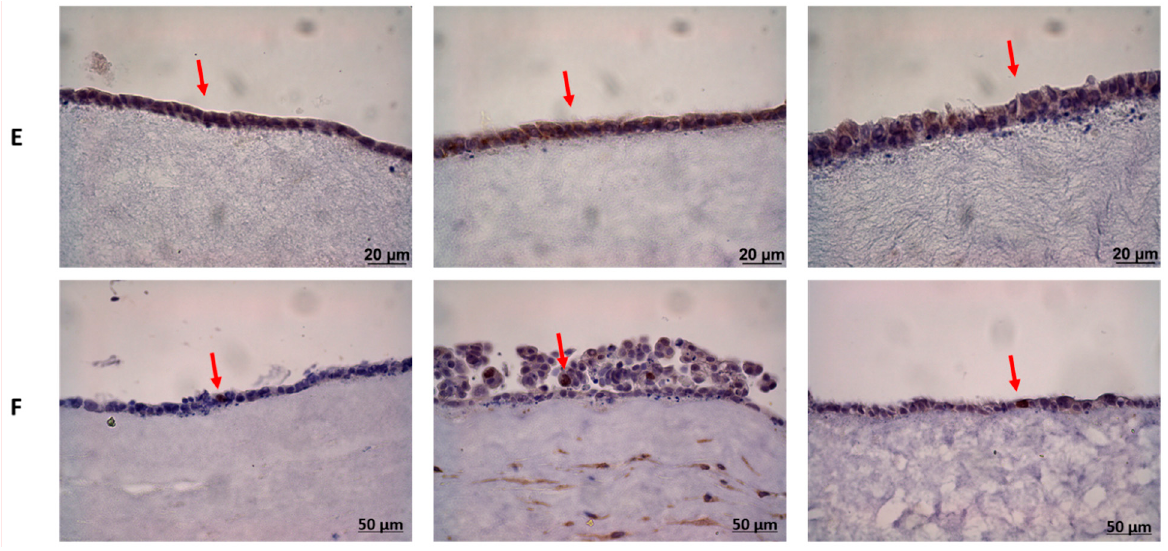
Figure 9. Histologic characterization of GTE after 72 h of treatment with periodontal gels and LPS stimulation. The images represent an example of ( A ) H&E staining of GTE; ( B ) Expression of vimentin (fibroblasts marker); ( C ) Expression of keratin 19 (epithelial differentiation marker); ( D ) expression of keratin 17 (epithelial differentiation marker); ( E ) Expression of involucrin (epithelial differentiation marker); and ( F ) Expression of Ki-67 (proliferation marker), images were taken at a magnification of 630× (Images of ( A – E )) and 400× (Images of ( F )). Negative control (C − ) was obtained from GTE treated with PBS.